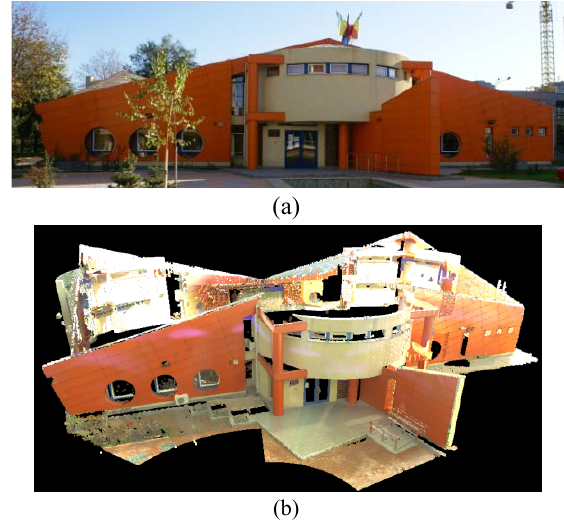
Figure 1. The study zone (a) Digital image (b) Textured point cloud, resulted from scanning process with ScanStation2 laser